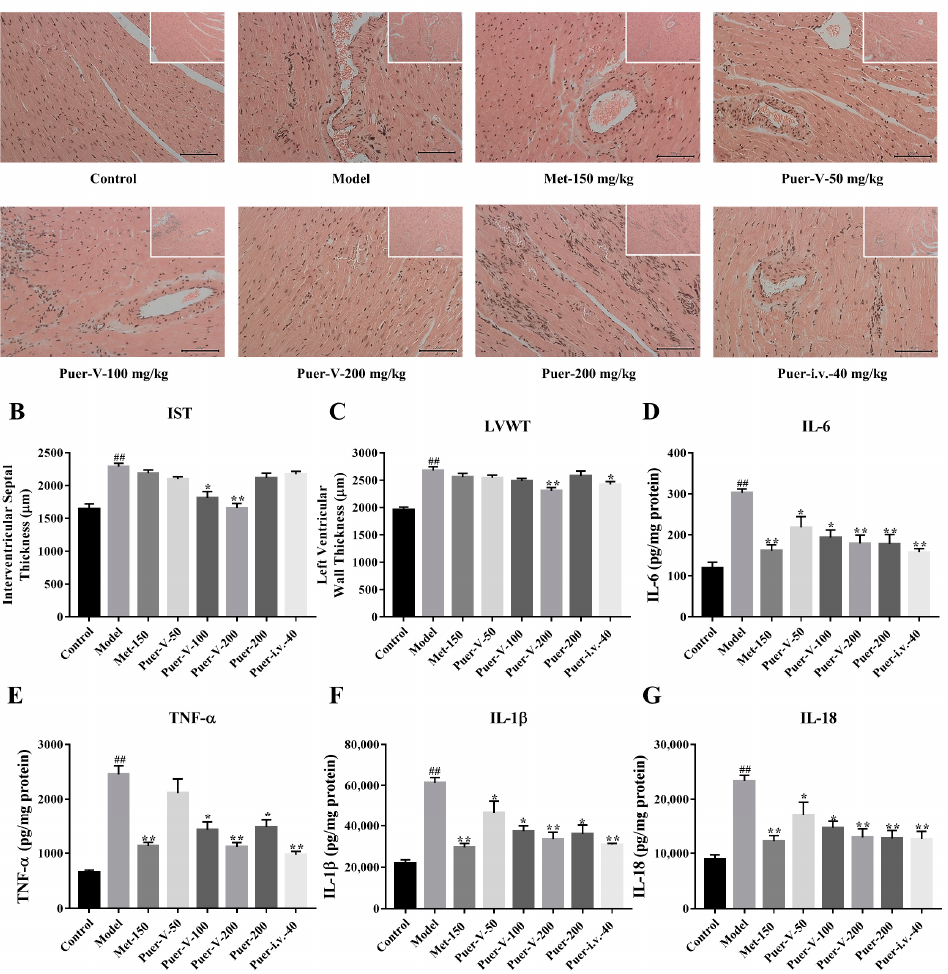
Figure 6. The DCM rats were protected from myocardial inflammation and necrosis by puerarin-V. ( A ) Histopathological changes in myocardium of mice subjected to diabetic cardiomyopathy rats (HE stain). Small images are 100 × , large images are 200 × . Scale bar: 100 µ m. ( B ) Effects of puerarin-V on IST. ( C ) Effects of puerarin-V on LVWT. ( D – G ) The quantitative analyses of IL-6, TNF- α , IL-1 β , and IL-18. The data are represented by mean ± SEM (n = 6–8). ## p < 0.01 vs. control group. * p < 0.05 and ** p < 0.01 vs. model